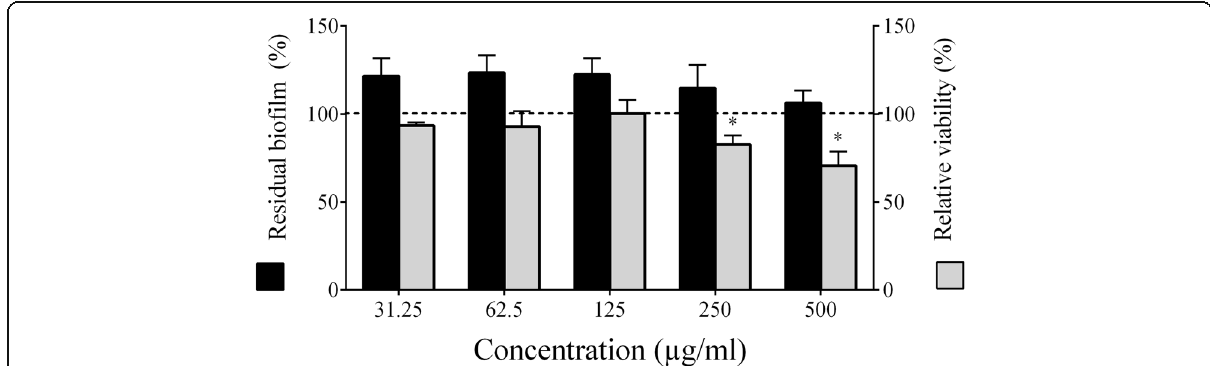
Fig. 3 Effect of highbush blueberry PACs on A. actinomycetemcomitans biofilm desorption and viability. ∗ : significantly different ( p < 0.01) from the control (no PACs; horizontal